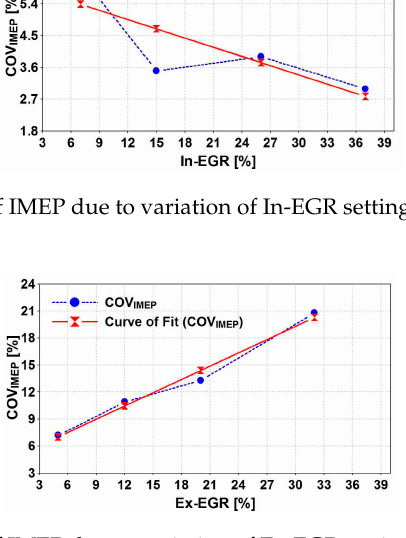
Figure 14. Influence of In/Ex-EGR on uHC and CO concentrations at idling and low/mid-load settings (rpm = 1000-3000, IMEP = 1-2.1 bar, T epc = 385-530 K, AFR = 14 – 16).